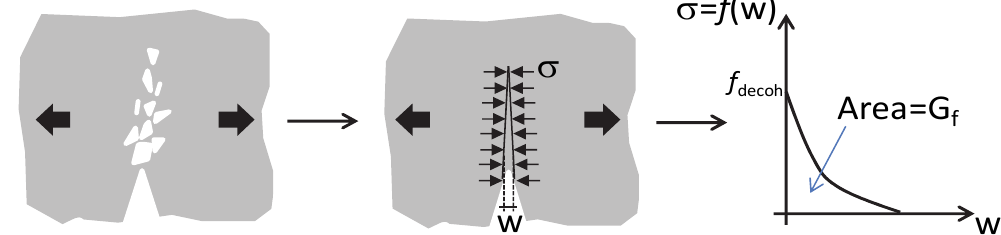
Figure 5: Meso-mechanics basis of the Cohesive Zone Model and parameters of the softening curve.